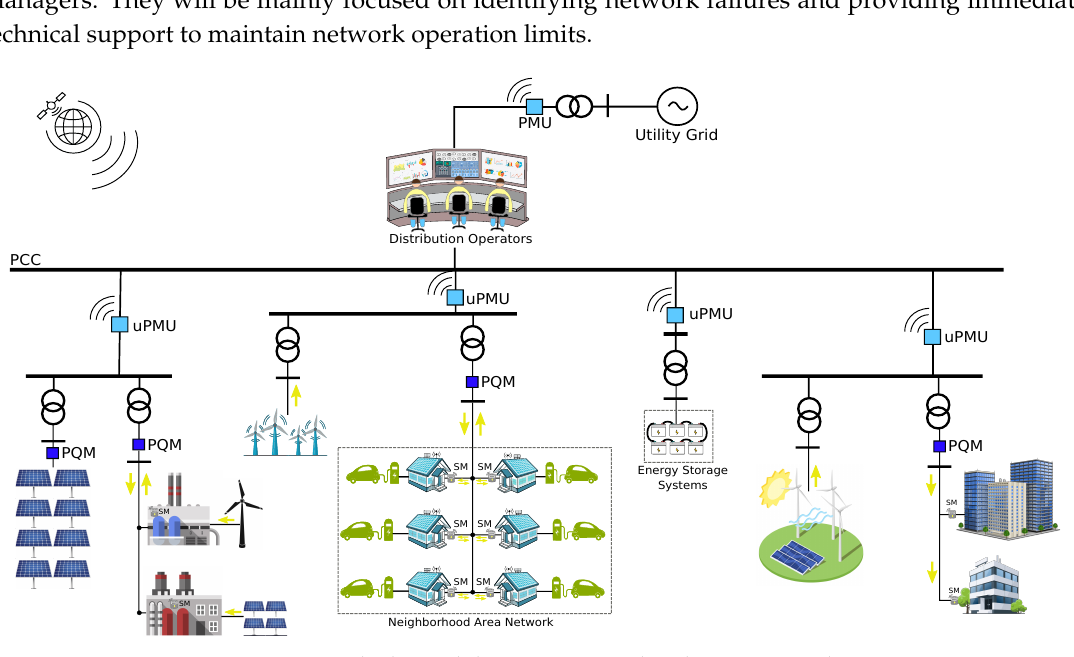
Figure 1. High observability in an active distribution